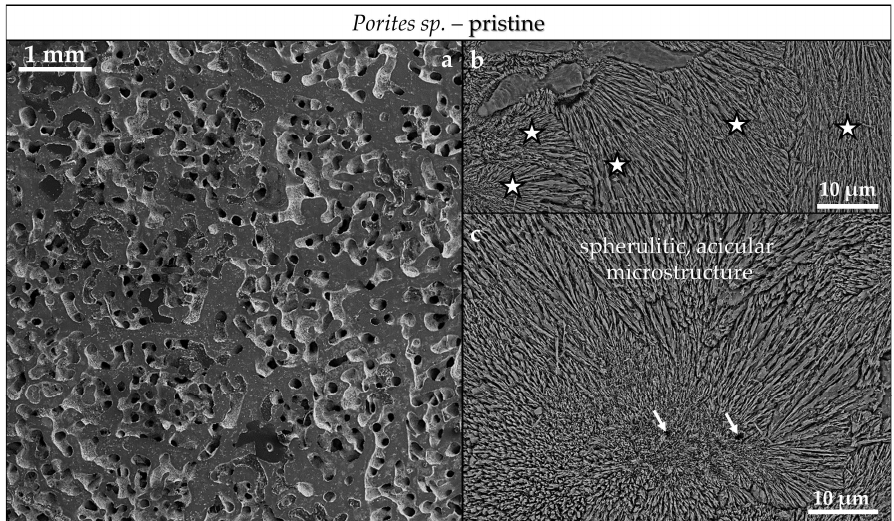
Figure A9. FE-SEM images depicting the macro- and microstructure of the skeleton of the modern coral Porites sp. ( a ) Due to its specific architecture comprising many thin vertical and transverse elements, the skeleton of Porites sp. has an exceedingly high surface area This does not imply that the skeleton is porous. The microstructure of Porites sp. (this study and Casella et al., 2018) comprises a multitude of differently sized spherulites, mineral units consisting of radially arranged acicles and fibrils ( b , c ). These nucleate at centers of calcification (white arrows in c ) and grow radially outward increasing in length until they abut the adjoining spherulite.